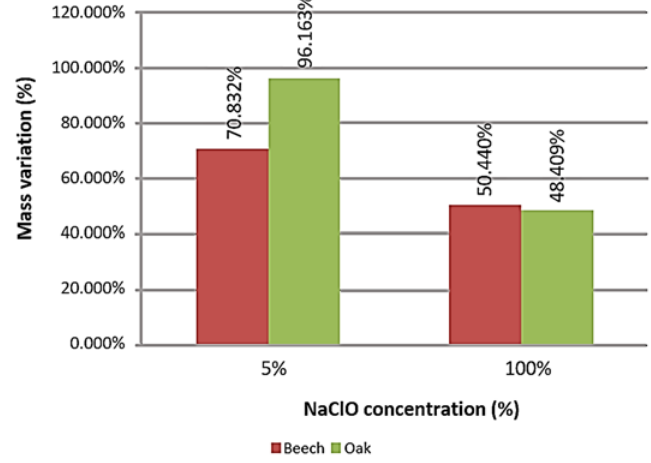
Figure 7. Mass variation of the large samples after three weeks of immersion.